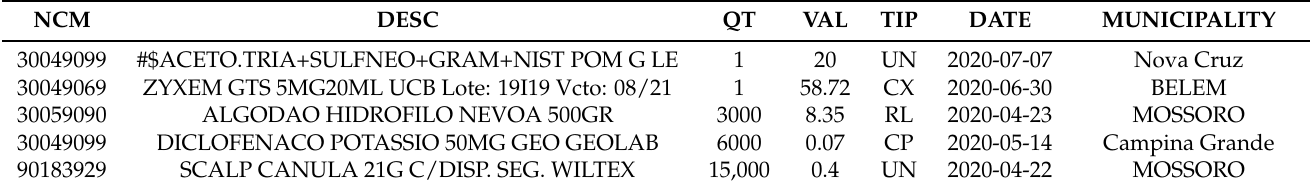
Table 1. Sample of the dataset used in